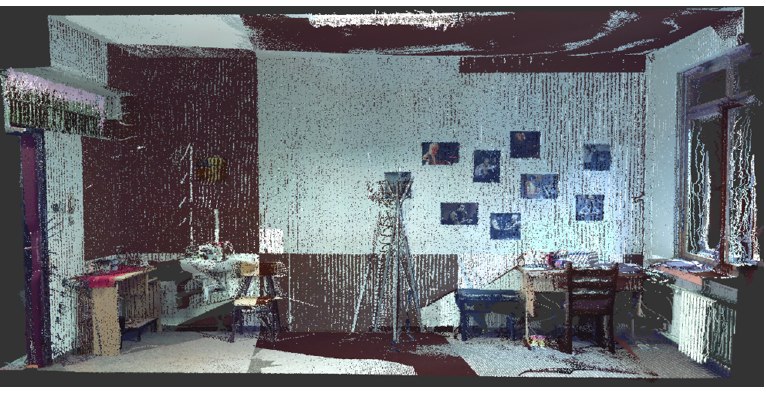
Figure 5. Original point cloud.